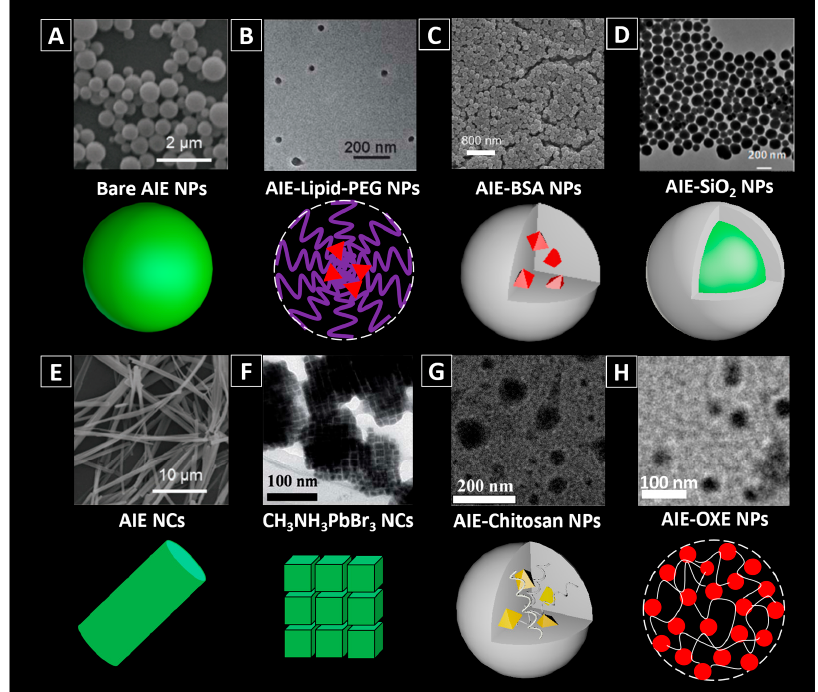
Figure 3. Different types of AIEgen-based nanomaterials. ( A ) bare AIE NPs [2,29]; ( B ) AIE-Lipid- poly(ethylene glycol) (PEG) NPs [2,24]; ( C ) AIE-BSA NPs [20]; ( D ) AIE-SiO 2 NPs [2,34]; ( E ) bare AIE NCs [29]; ( F ) CH 3 NH 3 PbBr 3 nanocrystals [38]; ( G ) AIE-Chitosan NPs [2,40]; ( H ) AIE-OXE NPs after